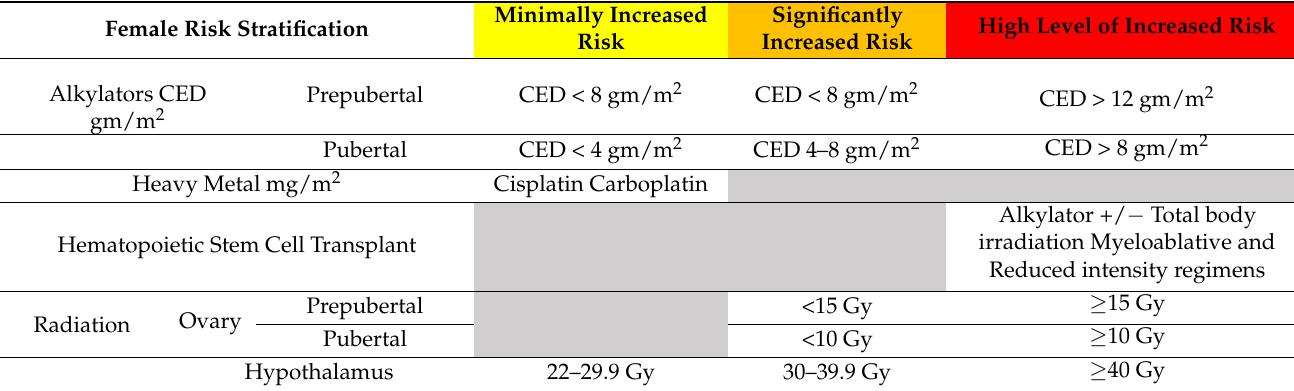
Table 2. New Female Risk Stratification